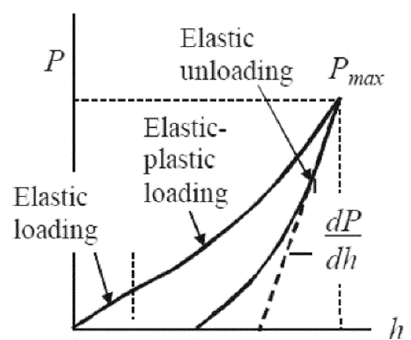
Figure 5. Typical force–indentation ( P − h ) curve for spherical indenter, in which the Oliver–Pharr model can be used in elastic unloading portion, and Hertz contact model can be used in elastic loading portion. Reproduced and adapted with permission from [49].